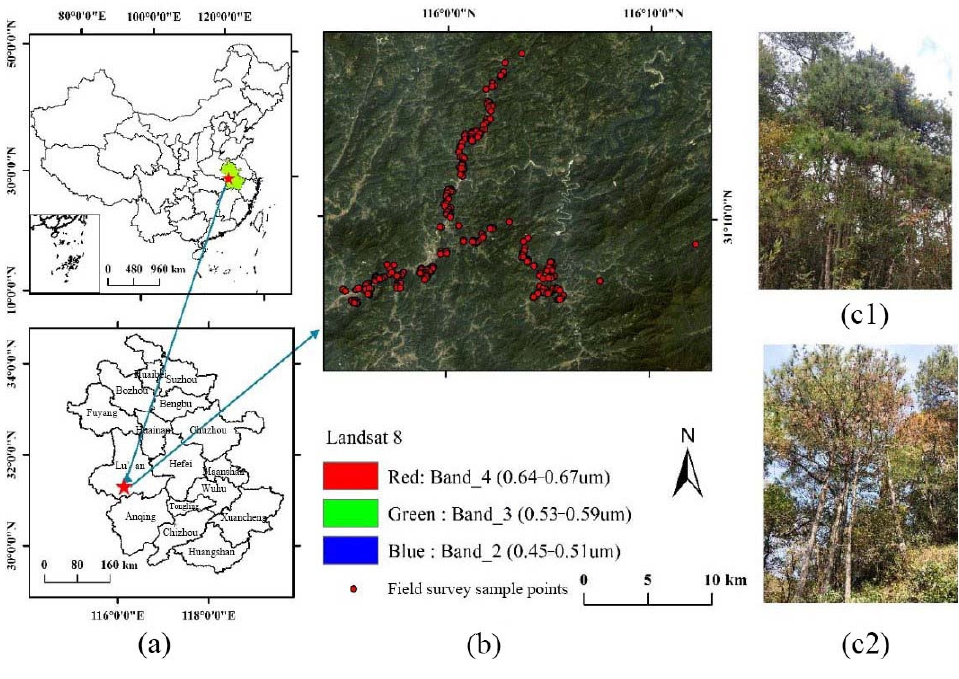
Figure 1. Location of study area and sample plot. ( a ) Location of the study area. ( b ) True color Landsat image and sample plot. ( c1 ) Picture of healthy pine trees in the study area. ( c2 ) Picture of infected pine trees in the study area.